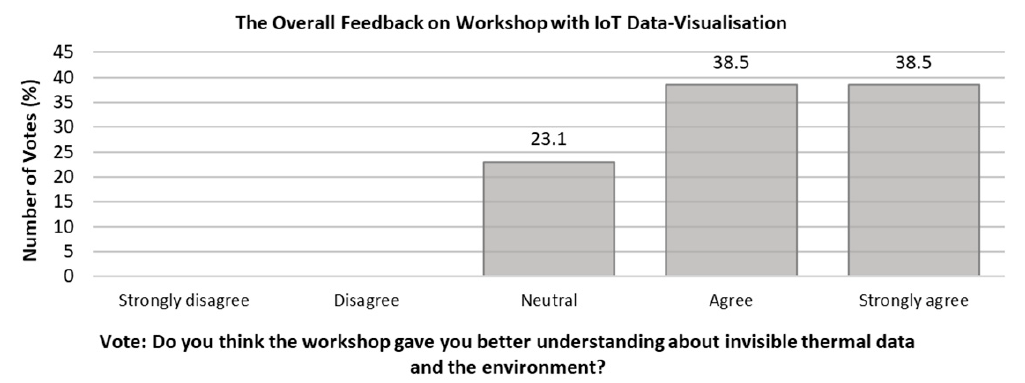
Figure 17. Overall feedback from students on workshop with IoT data visualisation (source: real-time questionnaire data from students).